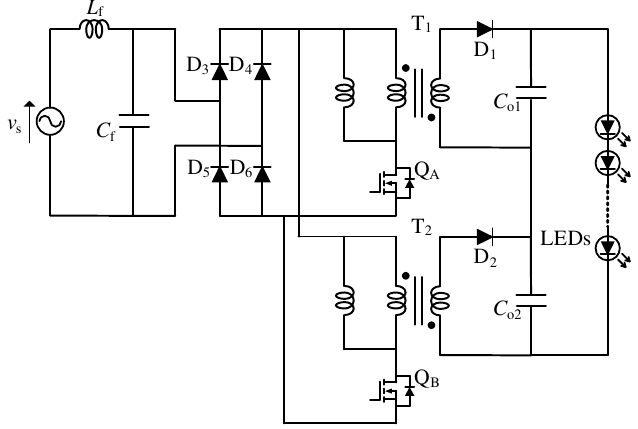
Figure 1. Previously proposed circuit diagram of light-emitting diode (LED) driver [4].